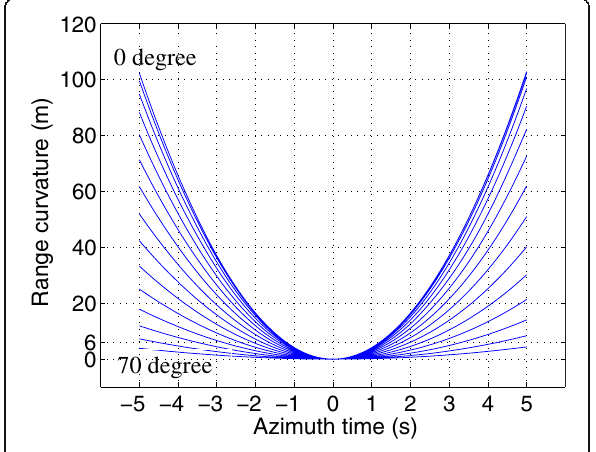
Fig. 2 High-order RCM with varying squint